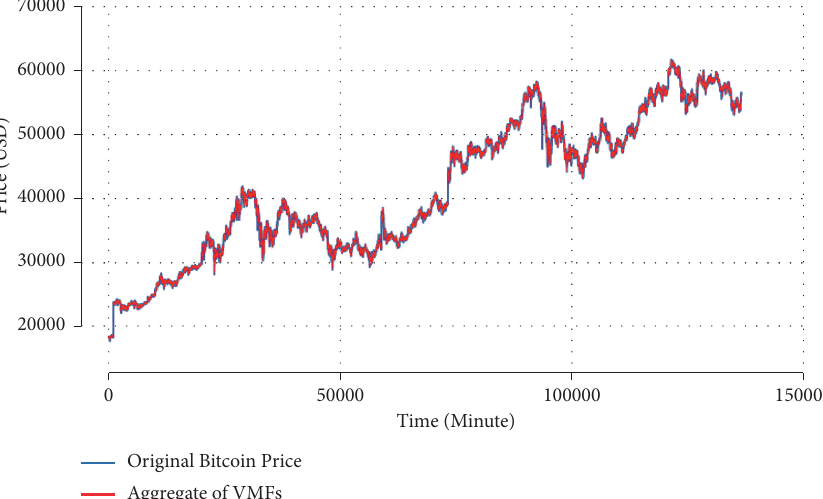
Figure 9: Reconstructed signal of VMF